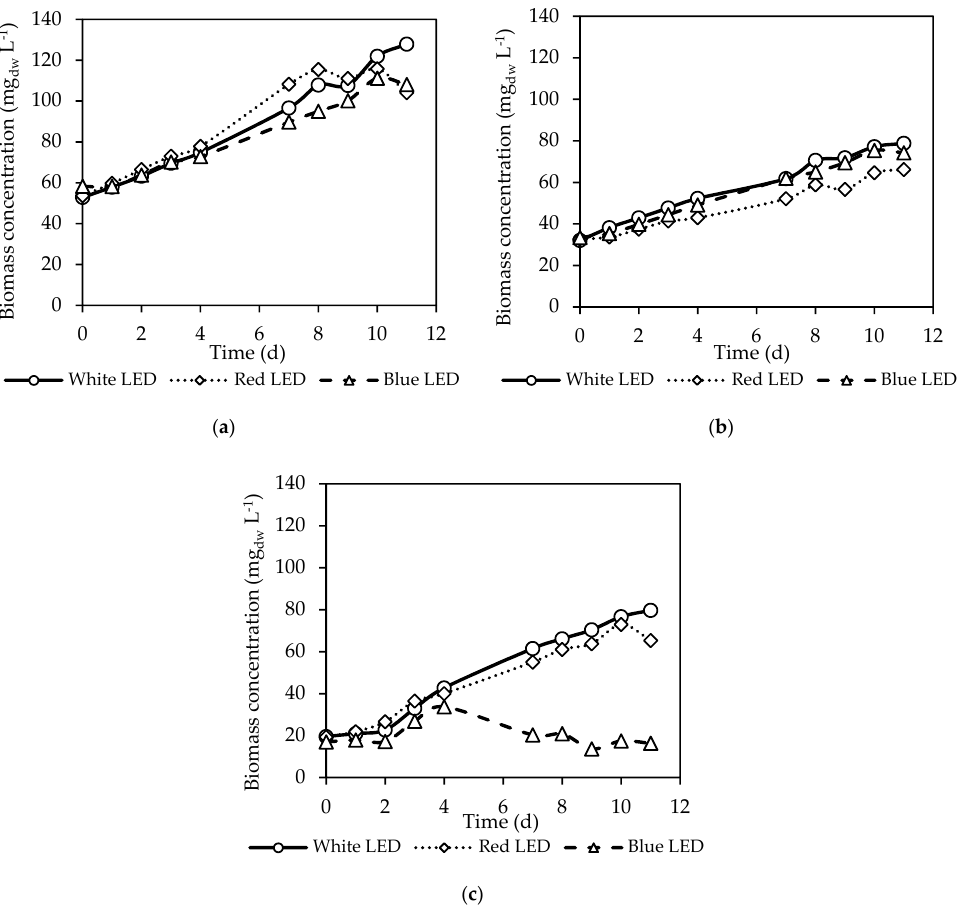
Figure 2. Growth curves obtained for ( a ) C. vulgaris , ( b ) T. obliquus and ( c ) N. oleoabundans under different light conditions (white, red and blue LEDs).